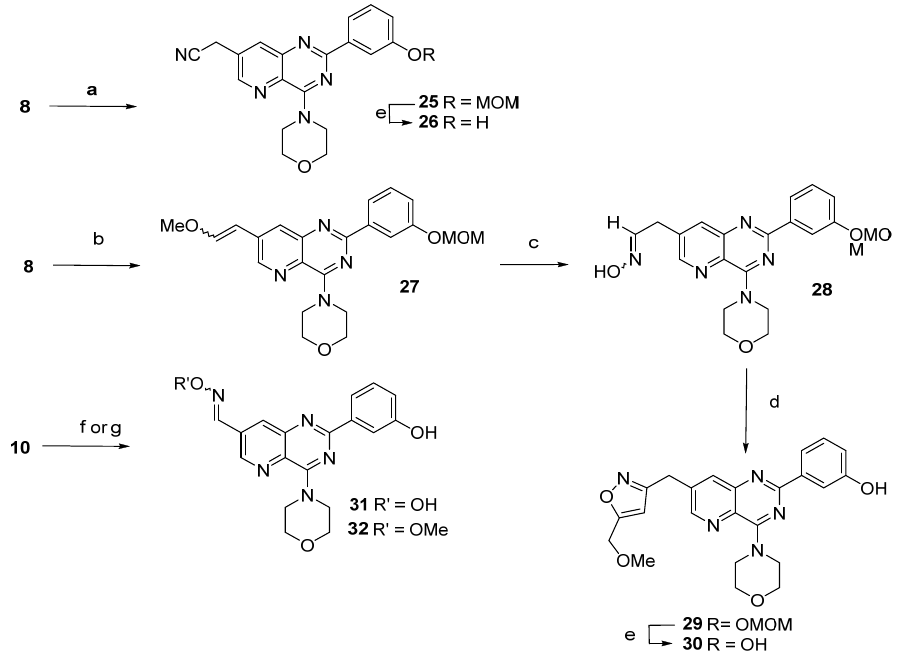
Table 1. Evaluation of PI3K inhibition.